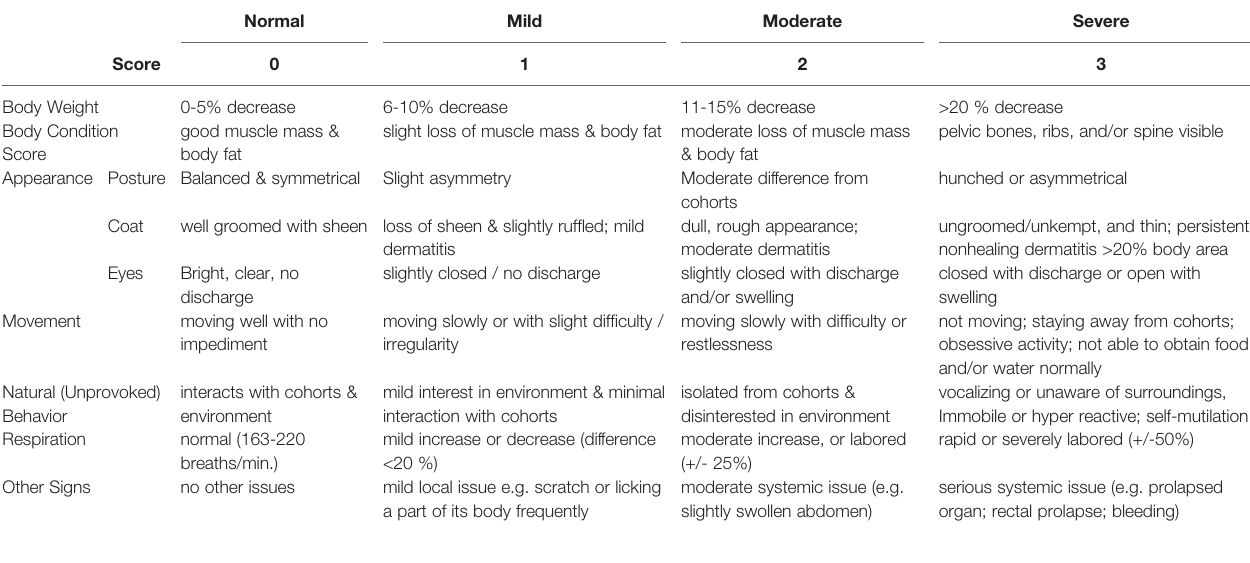
TABLE 1 | Criteria of Clinical Sickness